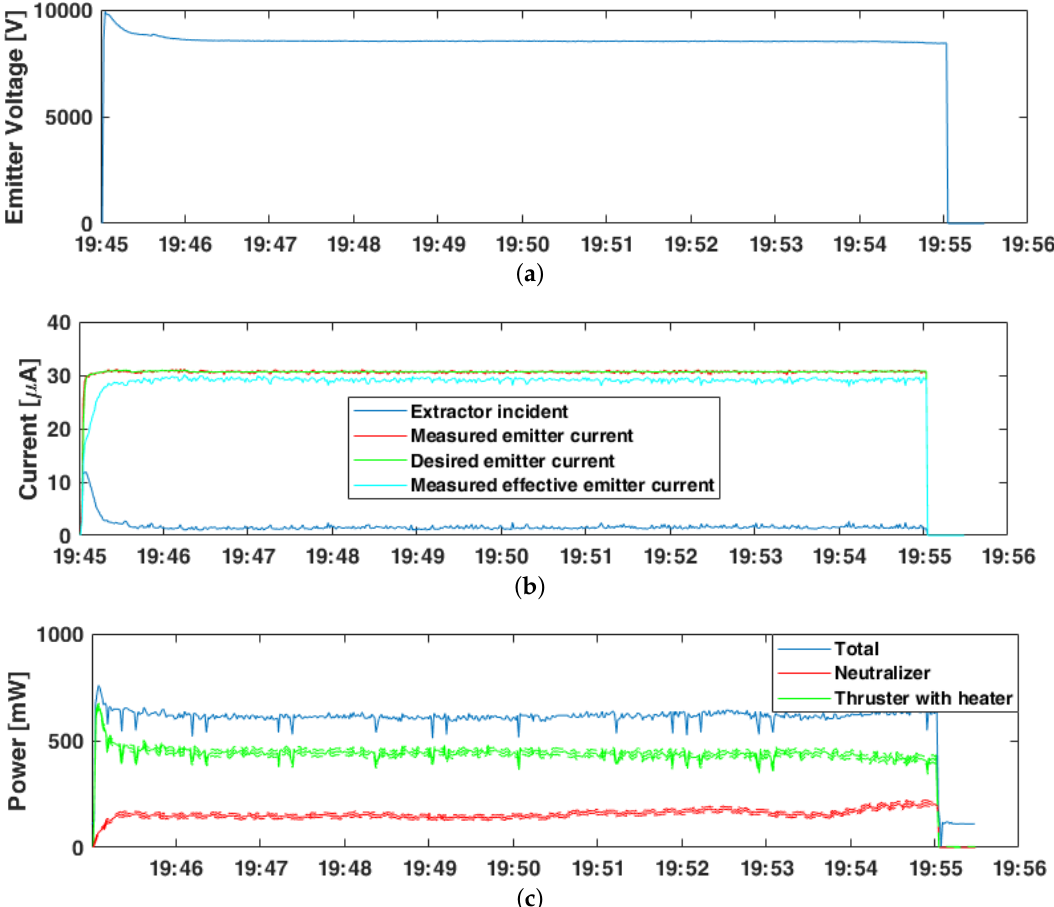
Figure 12. In-orbit activation of thruster B on 23 May 2020. ( a ) Emitter voltage U mon of thruster B. ( b ) The monitored currents of thruster B. ( c ) The power consumption of the PPU, the neutralizer, and the thruster with its associated heater within their